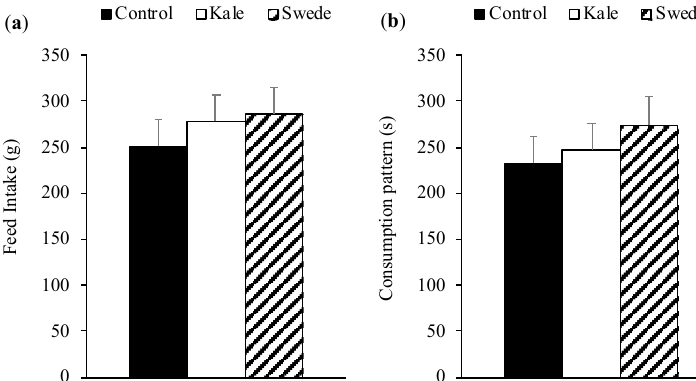
Figure 3. Least squares means ( + Standard Error) of pigs feed intake ( a ) and palatability expressed as consumption patterns; consumption time / number of approaches to the feeder ( b ) of corn–soybean base diets with the inclusion of 15% of kale, swede, or wheat middlings (control) when animals were offered one consumption option during 10 min. Table 3. Consumption pattern (CT / A) over 10 min from growing pigs ( n = 4) exposed to corn–soybean base diets with the inclusion of 15% of kale, swede, or wheat middlings as the control diet expressed by the first (0–5 min), last (6–10 min) and total (0–10 min) period of the test.